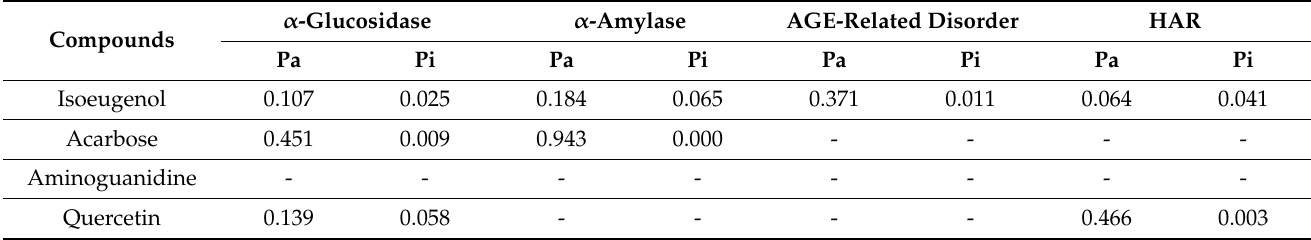
Table 10. PASS analysis of the representative